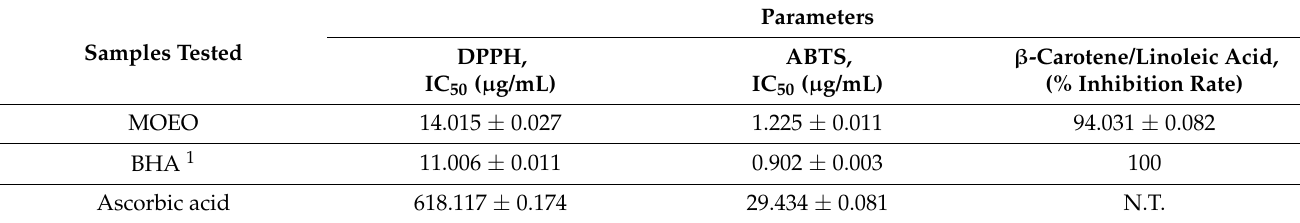
Table 3. Antioxidant activities of M. officinalis subsp. officinalis essential